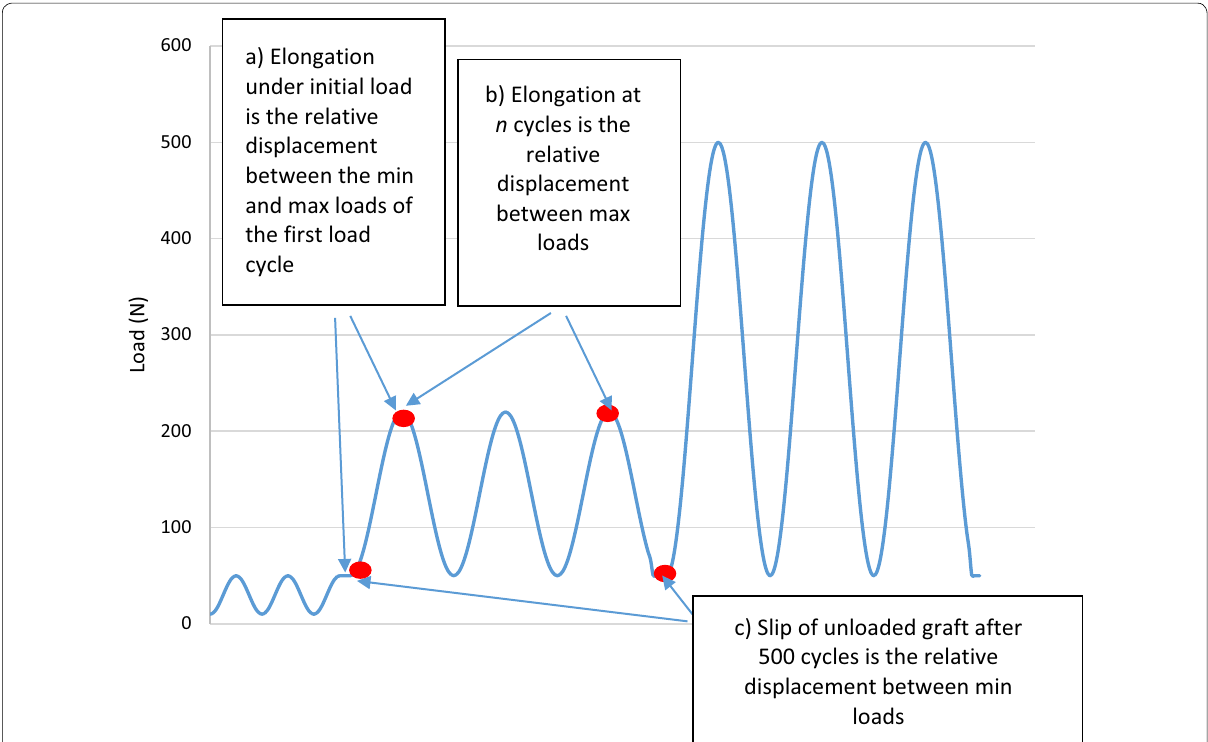
Fig. 5 Schematic indicating where measurements were captured in the load cycle for (a) elongation under initial load, (b) elongation at n cycles, and (c) slip of unloaded graft after 500